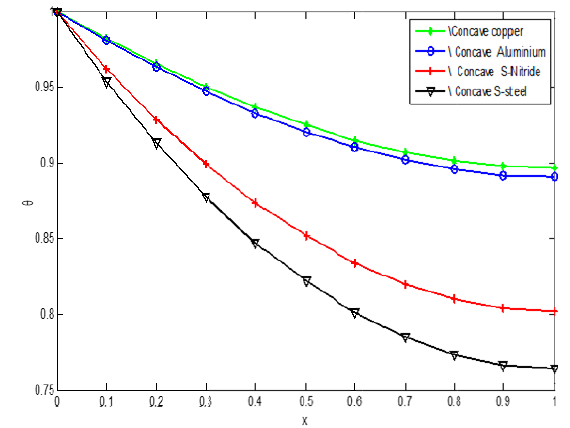
Figure 6. Effect of different materials on non-dimensional temperature distribution of fin with concave profile